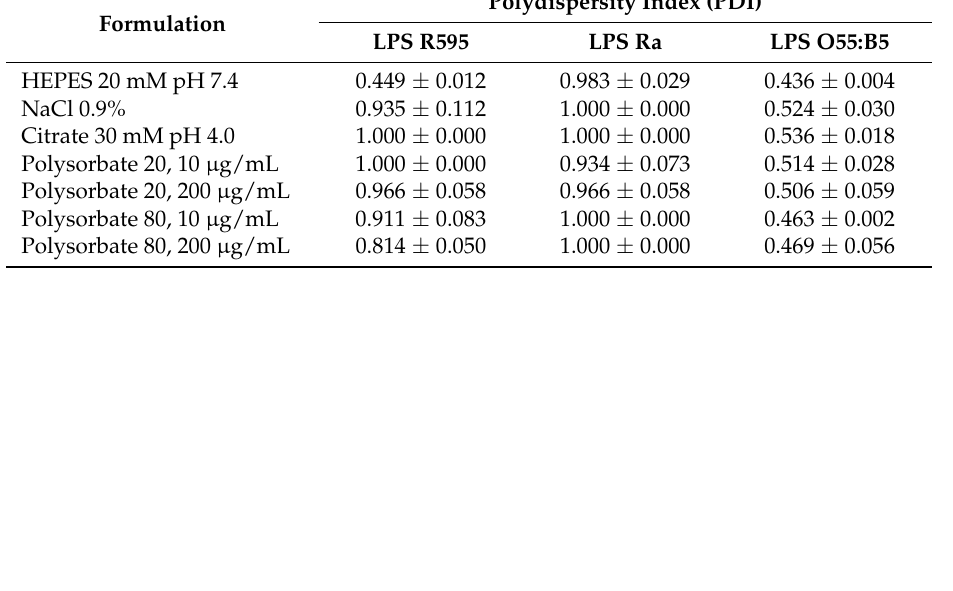
Figure 4. LPS-induced secretion of TNF- α by human mononuclear cells with different LPS formulations. LPS from E. coli O55:B5 ( A ), LPS R345 ( B ), and buffers and LPS control dissolved in water ( C ). Stimulation of human mononuclear cells was made at the three concentration: 1.0, 0.1 and 0.01 ng/mL, and the activity is recalculated. The error bar results from twofold measurement of TNF- α in the ELISA.